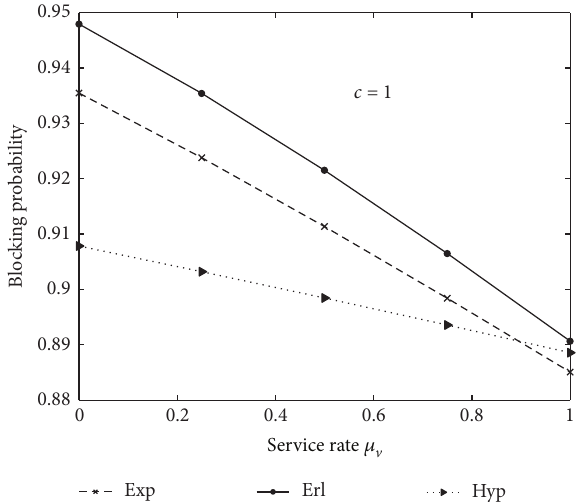
Figure 13: Blocking probability versus vacation-service rate with 𝜌 = 0.9 , 𝜃 = 1 , 𝜉 = 1 , and 𝑐 = 1 .